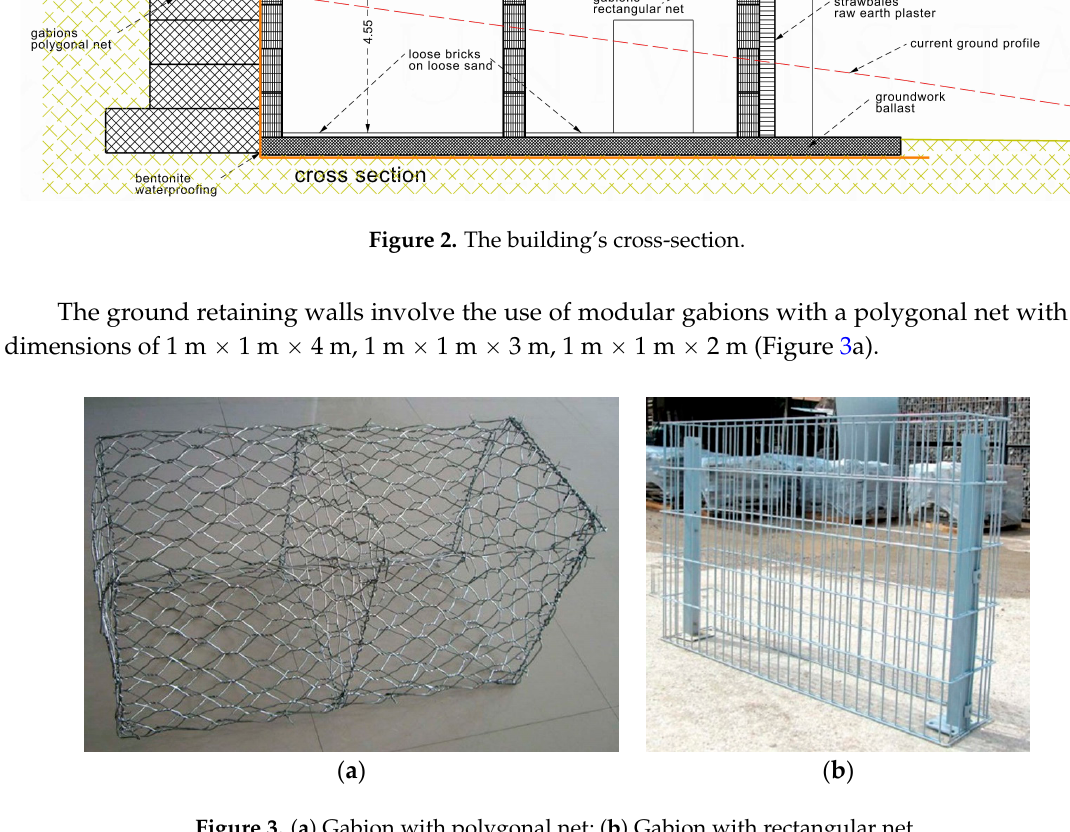
Figure 3. ( a ) Gabion with polygonal net; ( b ) Gabion with rectangular net.